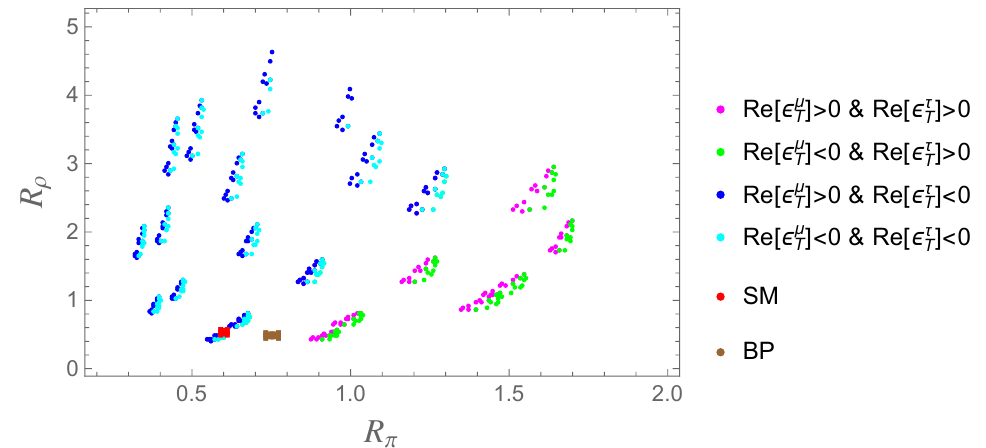
Figure 13. R ρ vs R π correlation when only the tensor operator is included in (1). The colors correspond ) and Re ( (cid:101) τ ) in the range of the parameter space. The red and brown to the different signs of Re ( (cid:101) µ T T points correspond to SM and NP at the benchmark